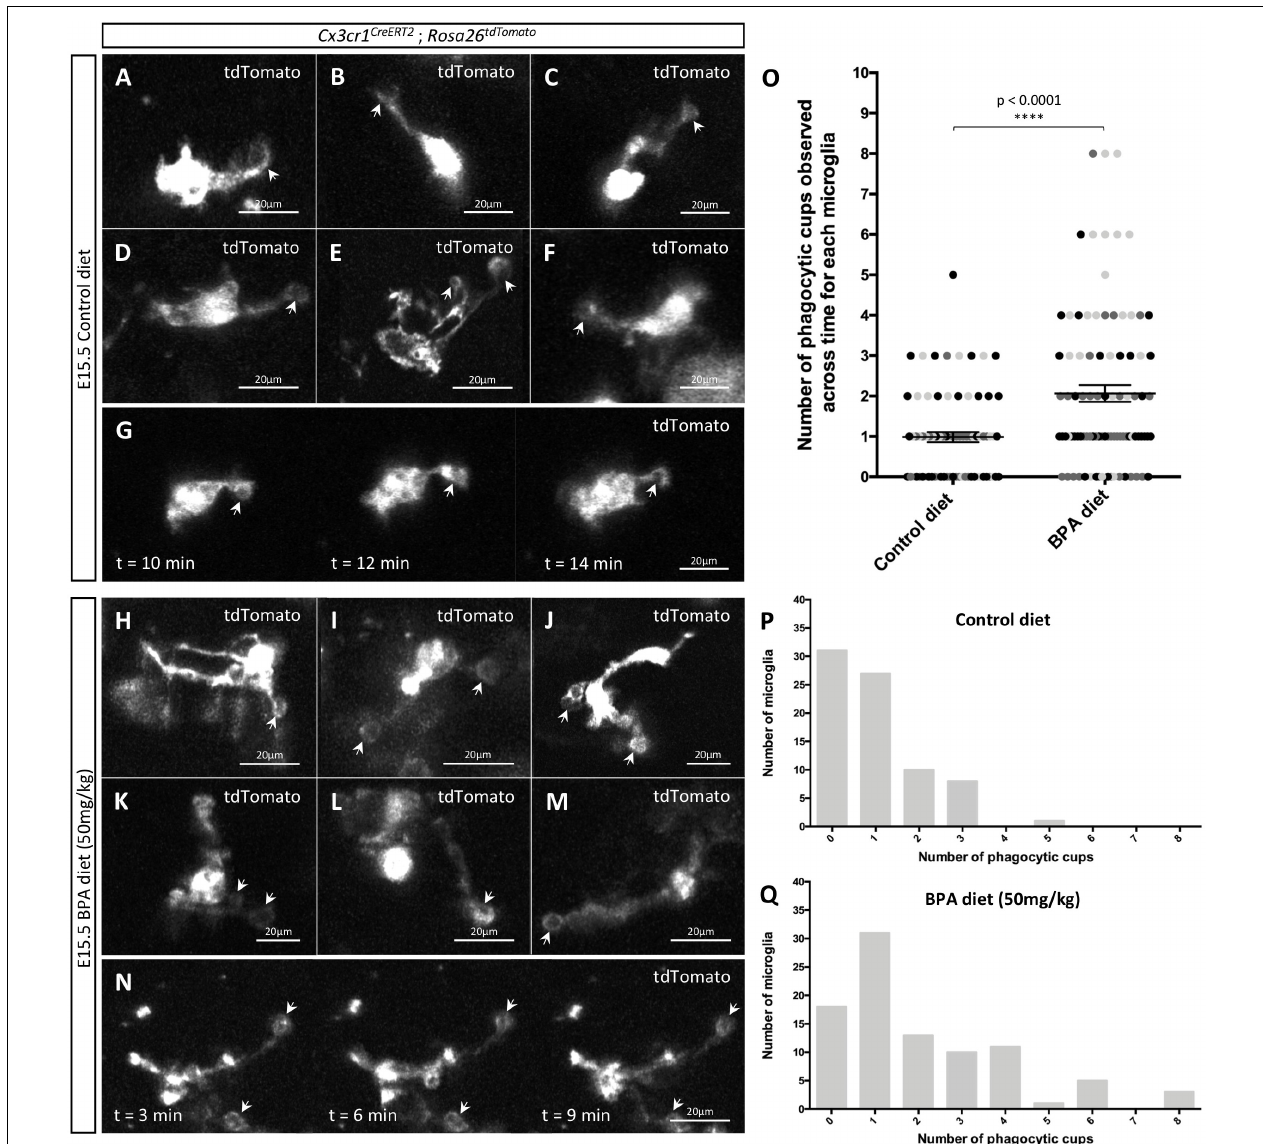
FIGURE 4 | Gestational BPA exposure increases the number of microglial phagocytic cups observable in the hypothalamus during embryogenesis. (A–N) Stills taken from live-cell imaging videos of E15.5 control (A–G) and high dose BPA exposed (H–N) Cx3cr1 CreERT 2 ; Rosa26 tdTomato double transgenic hypothalamic brain slices, where microglia are labeled with tdTomato and white arrows point to phagocytic cups. (G,N) Stills highlighting microglial phagocytic cup activity in control (G) and high dose BPA exposed (N) embryos across time. (O) Quantification of the number of phagocytic cups observed across the entire 5-h live-cell imaging video for each E15.5 control and high dose BPA exposed microglia in Cx3cr1 CreERT 2 ; Rosa26 tdTomato double transgenic hypothalamic brain slices ( n = 3; p < 0.0001). Dots that are the same color represent individual microglia from the same embryo/video, while different colored dots represent microglia from different embryos/videos. (P,Q) Quantification of the total number of microglia with a defined number of total phagocytic cups documented across 5-h live-cell imaging videos using E15.5 control ( P ; n = 3) or high dose BPA exposed ( Q ; n = 3) Cx3cr1 CreERT 2 ; Rosa26 tdTomato double transgenic hypothalamic brain slices. ∗∗∗∗ p <